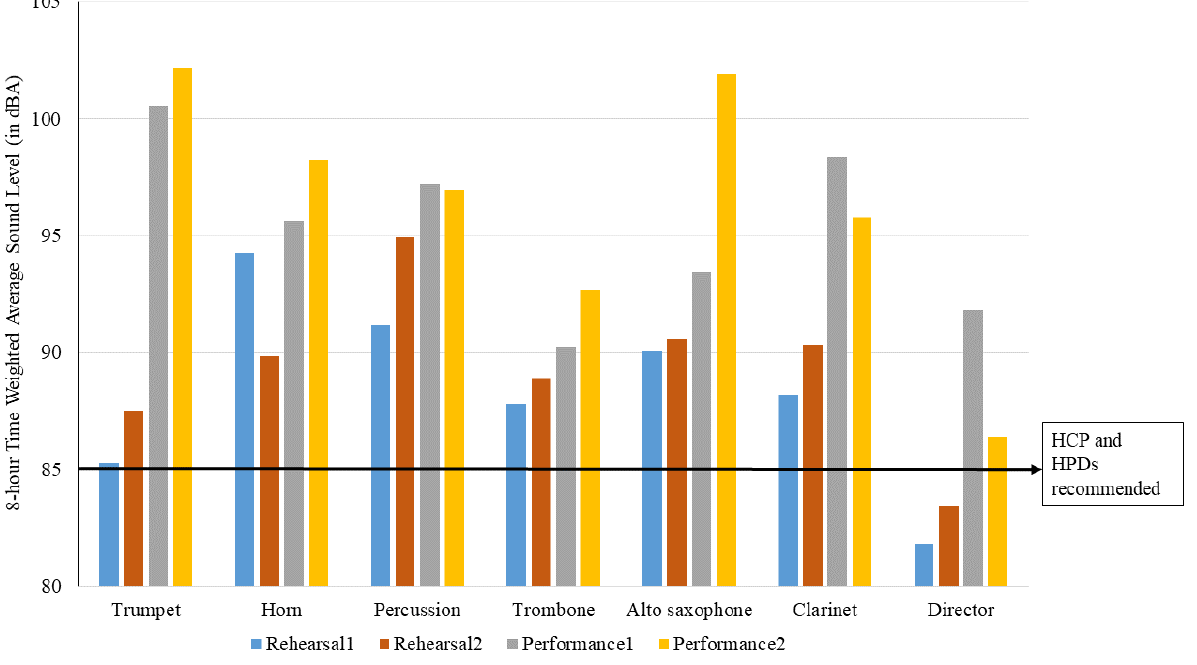
Figure 2. NIOSH 8 h time-weighted average sound levels for participants as a function of instrument type. Also shown are the levels at which NIOSH would recommend participation in a hearing conservation program (HCP) and the use of hearing protective devices (HPDs). Table 3. Minima, maxima, means, and standard deviations of sound exposure among marching band members.